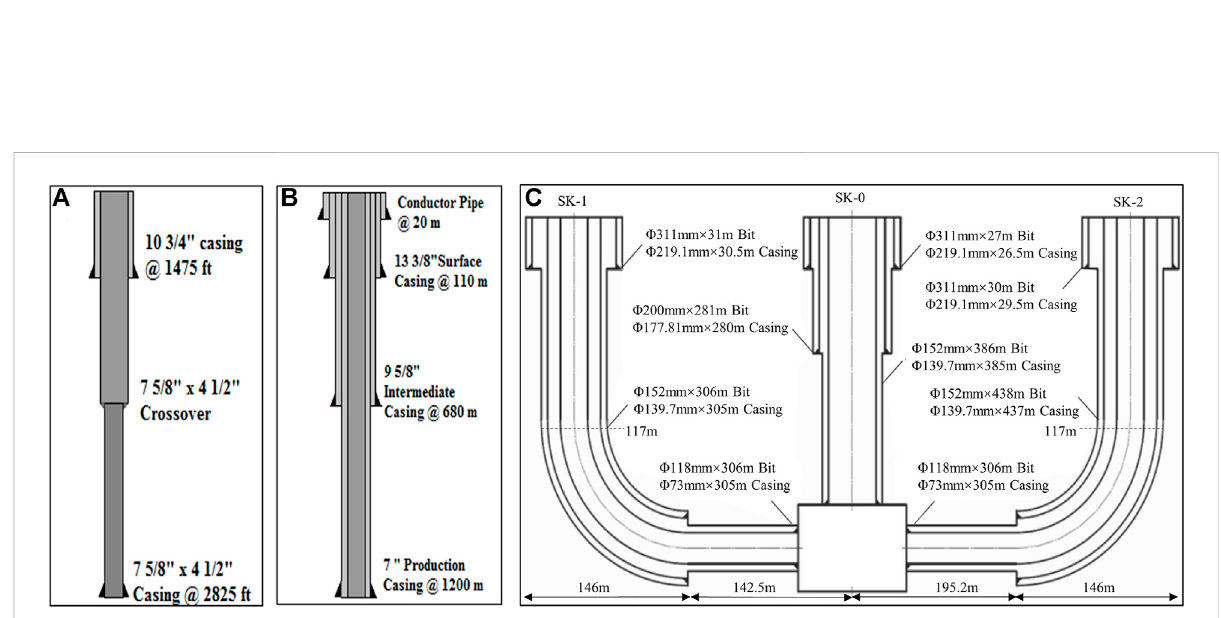
FIGURE 5 Wellbore structures of permafrost gas hydrate pilot production wells. (A) the well Ignik Sikumi # 1 in Alaska, (B) the well Mallik 5L-38 in Mackenzie Delta, and (C) the well SK in Qilian Mountains. (Merey, 2016; Li et al., 2017b; Merey, 2019; Zhu et al., 2020).